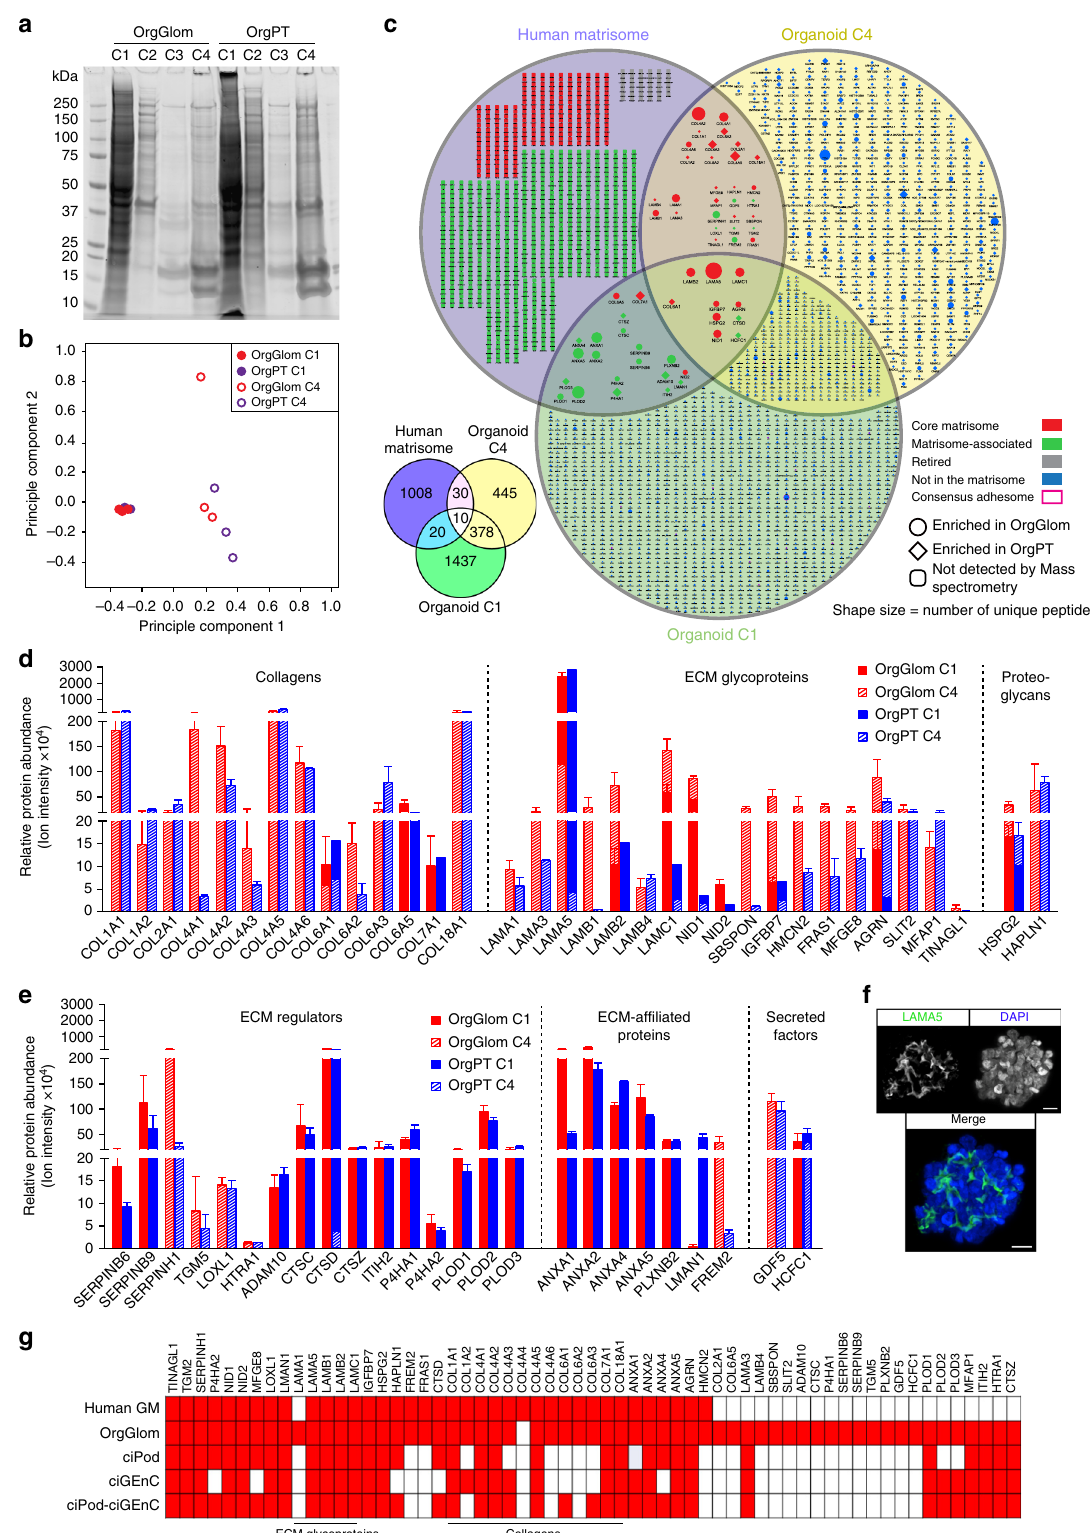
concentrations of doxorubicin. MAFB-BFP2 intensity was assessed via live imaging at 48 h post-treatment, revealing loss of BFP2 signal and fragmentation of glomeruli with increasing dose (Fig. 7a). Fixation of glomeruli followed by immunos- taining for the apoptosis marker caspase-3 showed an increase